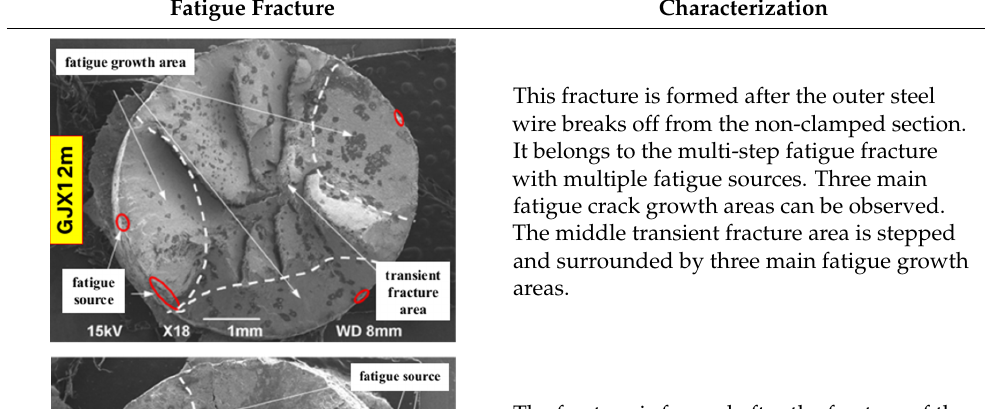
Table 3. Analysis of fatigue fracture characteristics of rusted steel strands.